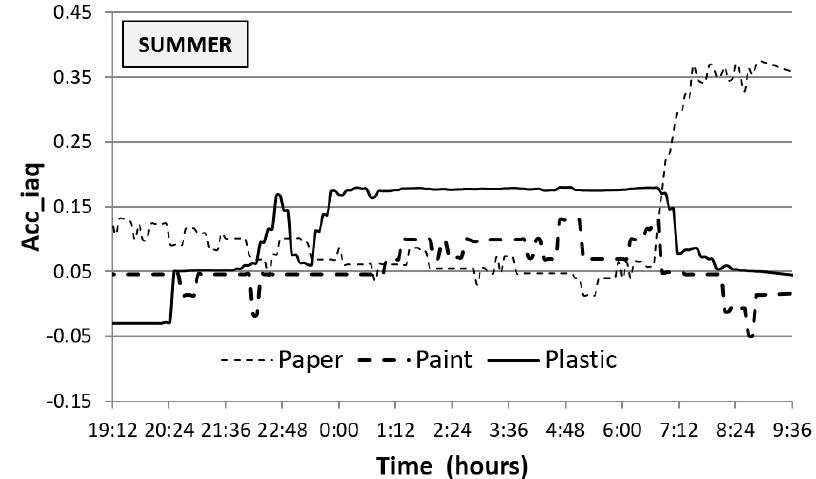
Figure 10. Indoor air acceptability (ACC IAQ ) predicted for each internal covering material during the summer season.